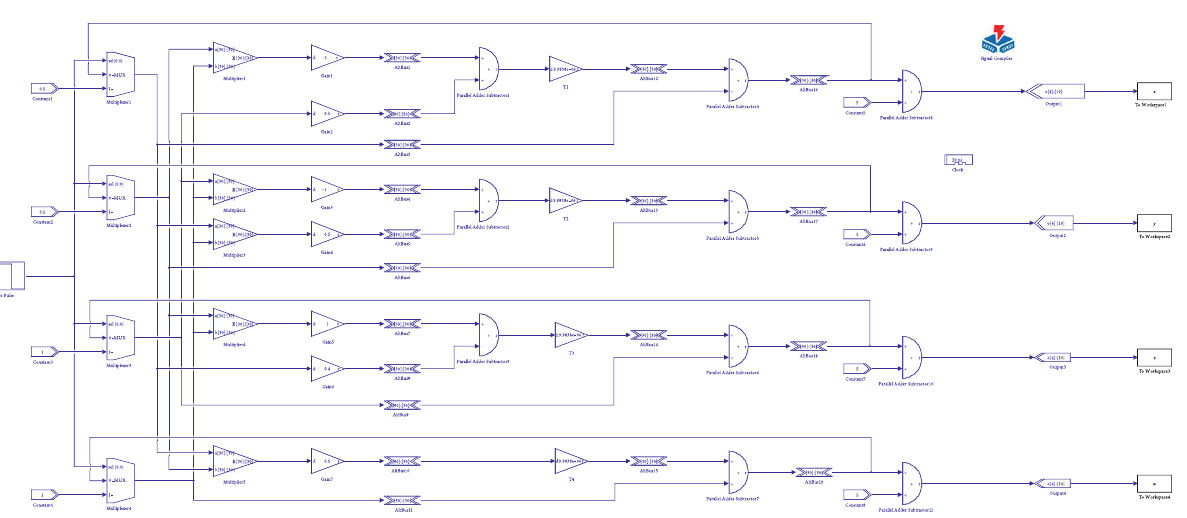
Figure 15: DSP Builder model of Case 1 and Case 2